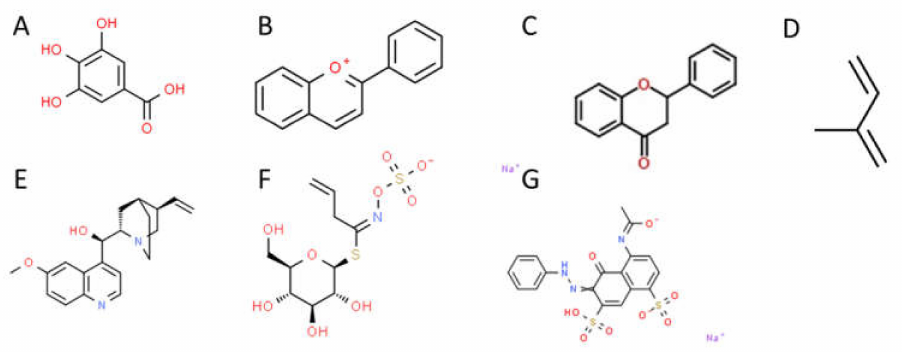
Figure 2. Basic structure of secondary metabolite classes with known antimicrobial properties. ( A ) Tannin (gallic acid). ( B ) Anthocyanin (flavylium). ( C ) Flavonoid. ( D ) Terpenoid (isoprene). ( E ) Alykyloid (quinine). ( F ) Allylglucosinolate. ( G ) Polyphenol